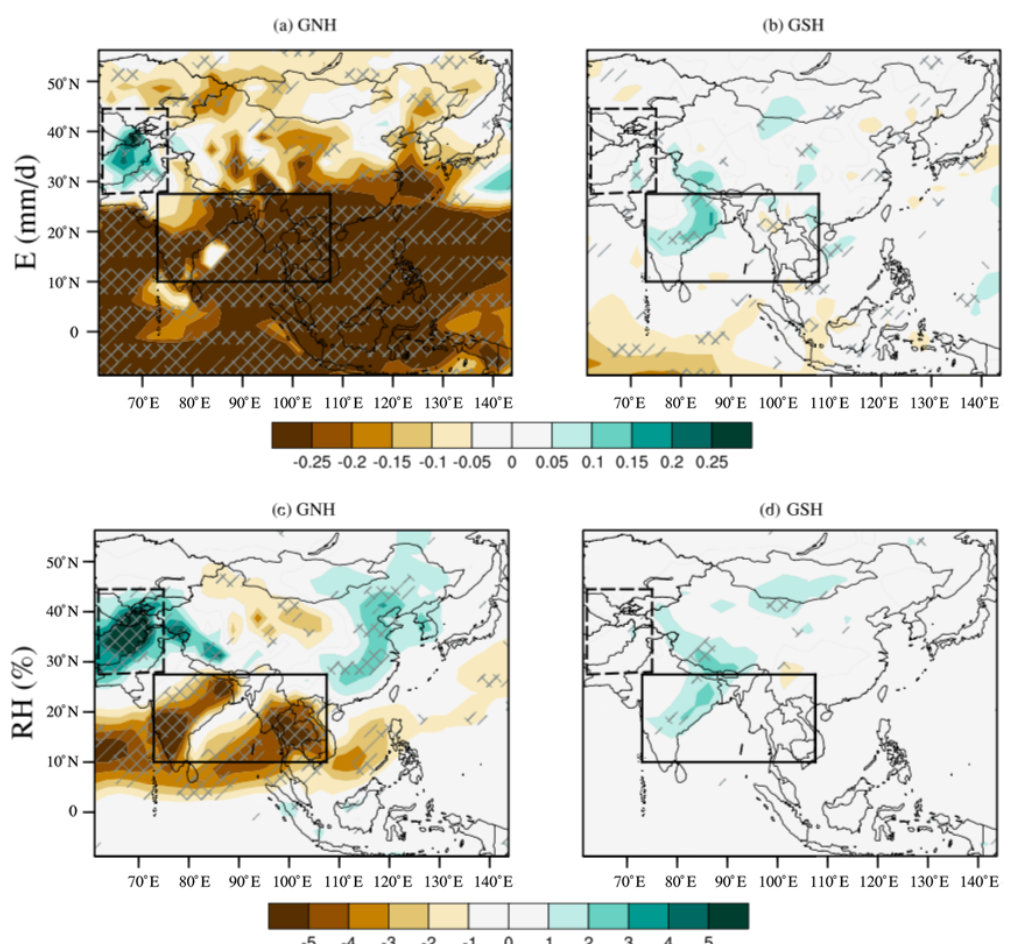
Figure 11. Spatial distribution of evaporation ( E ; mmd − 1 ; a , b ) and relative humidity (RH; %; c , d ) anomalies in the eruption year with respect to the mean of 5 years before the eruption. The solid and dashed black boxes indicate the relatively wettest area (RWA) and relatively driest area (RDA). The gray slashes and cross signs indicate the significant results at the 95% and 99% confidence